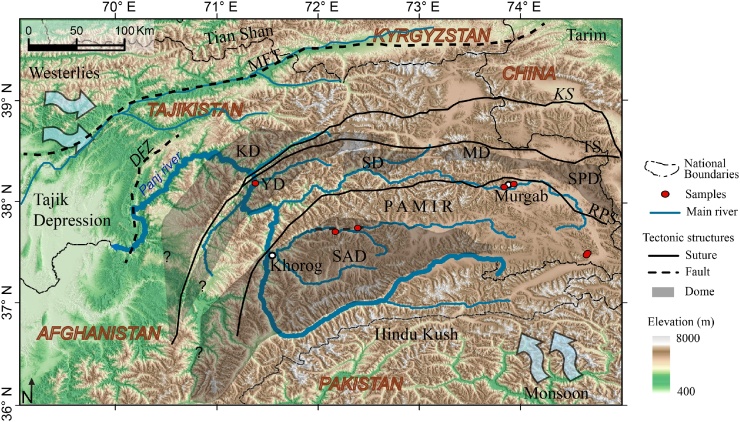
Map of the Pamir with the Panj River drainage. Atmospheric circulations, geologic structures, and sample localities are marked. Abbreviations: DFZ, Darvaz Fault Zone; MFT, Main Frontal Thrust; KS, Kunlun Suture; TS, Tanymas Suture; RPS, Rushan-Pshart Suture; KD, Kurgovat Dome; MD, Muskol Dome; SPD, Shatput Dome; YD, Yazgulom Dome; SD, Sarez Dome; SAD, Shakhdara-Alichur Dome.